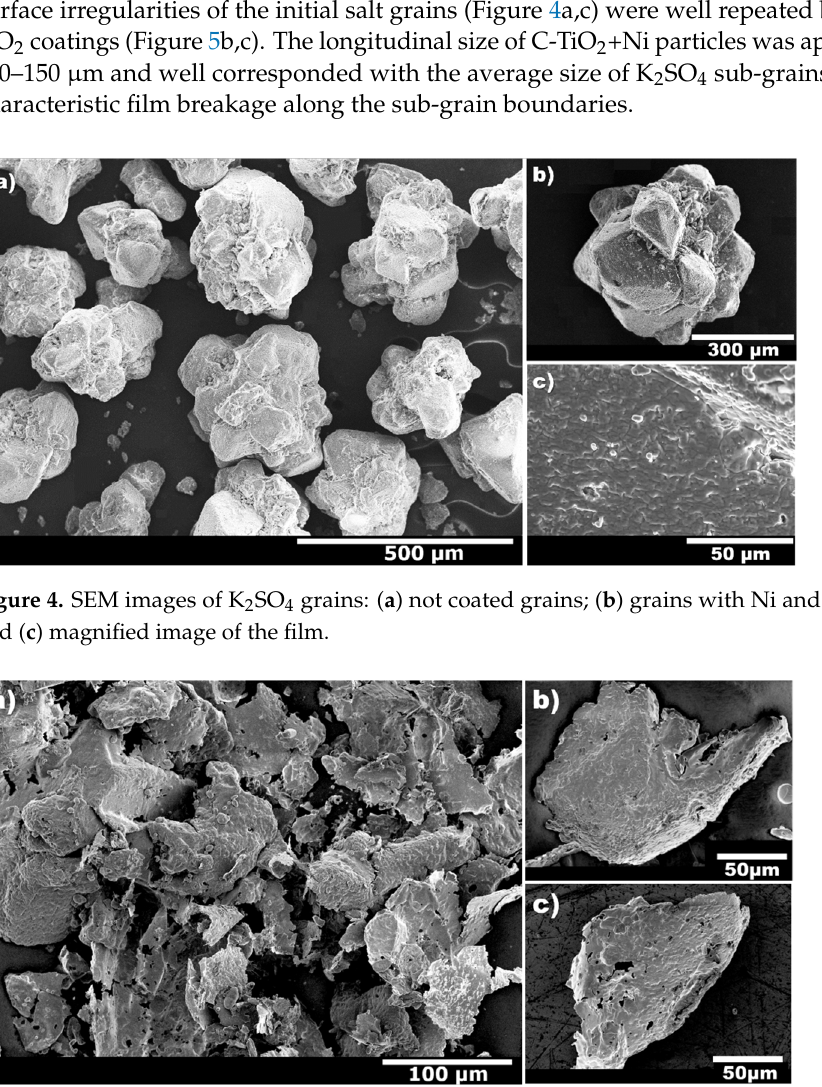
(Figure 7) complements the EDS data and confirms that magnetic photocatalyst powder had metallic Ni and TiO 2 (anatase + rutile) crystal phases.